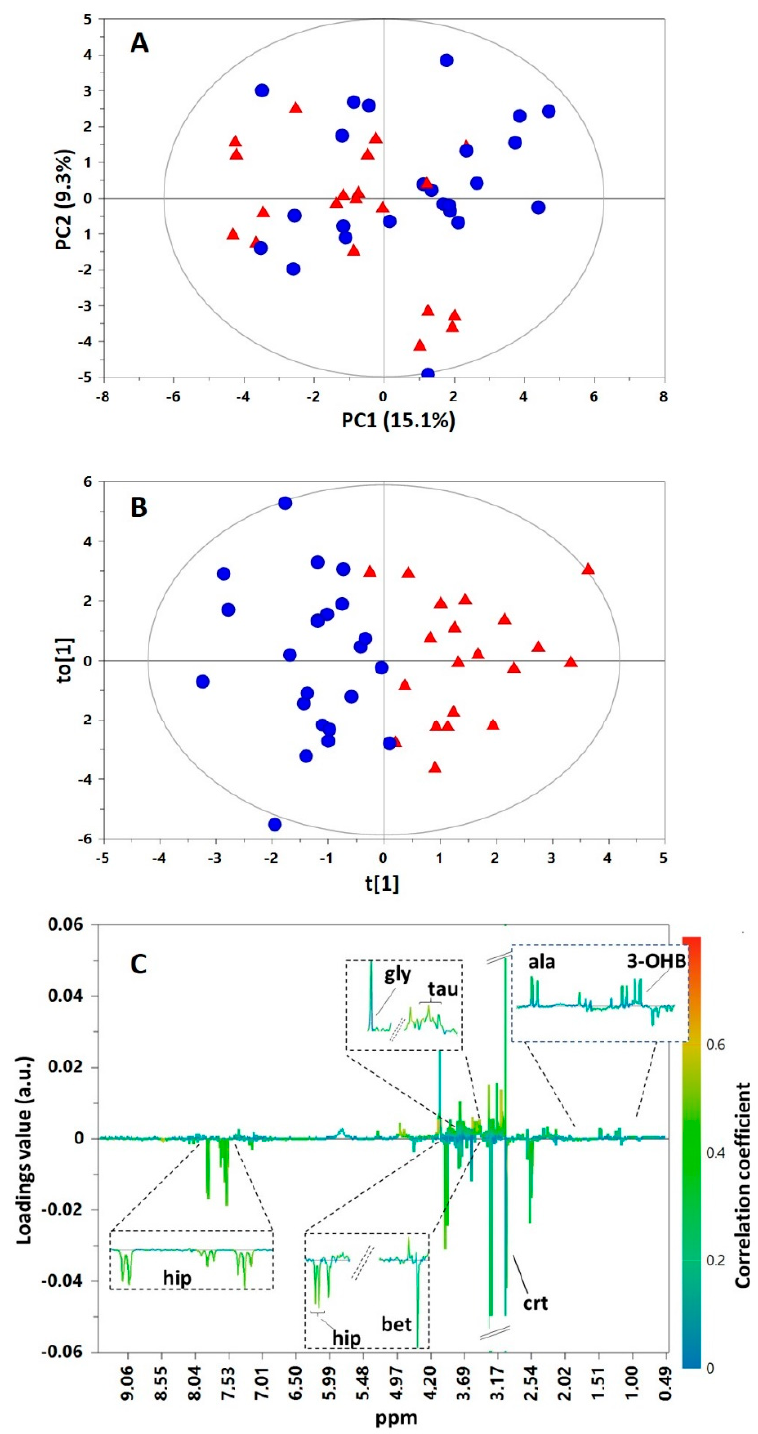
Figure 1. PCA scores plot ( A ), OPLS − DA scores plot ( B ), and correlation coefficient S-line plot ( C ) for the pairwise comparison between BAV ( ▲ ) and controls ( ● ). Abbreviation: 3-OHB, 3-hydroxybutyrate; ala, alanine; bet, betaine; crt, creatine; gly, glycine; hip, hippurate; tau, taurine. The analysis of the OPLS-DA correlation coefficient S-line plot suggested that the BAV metabolic signature primarily responsible for class separation comprised a panel of seven metabolites (Figure 1C). In particular, the levels of urinary 3-hydroxybutyrate (3-